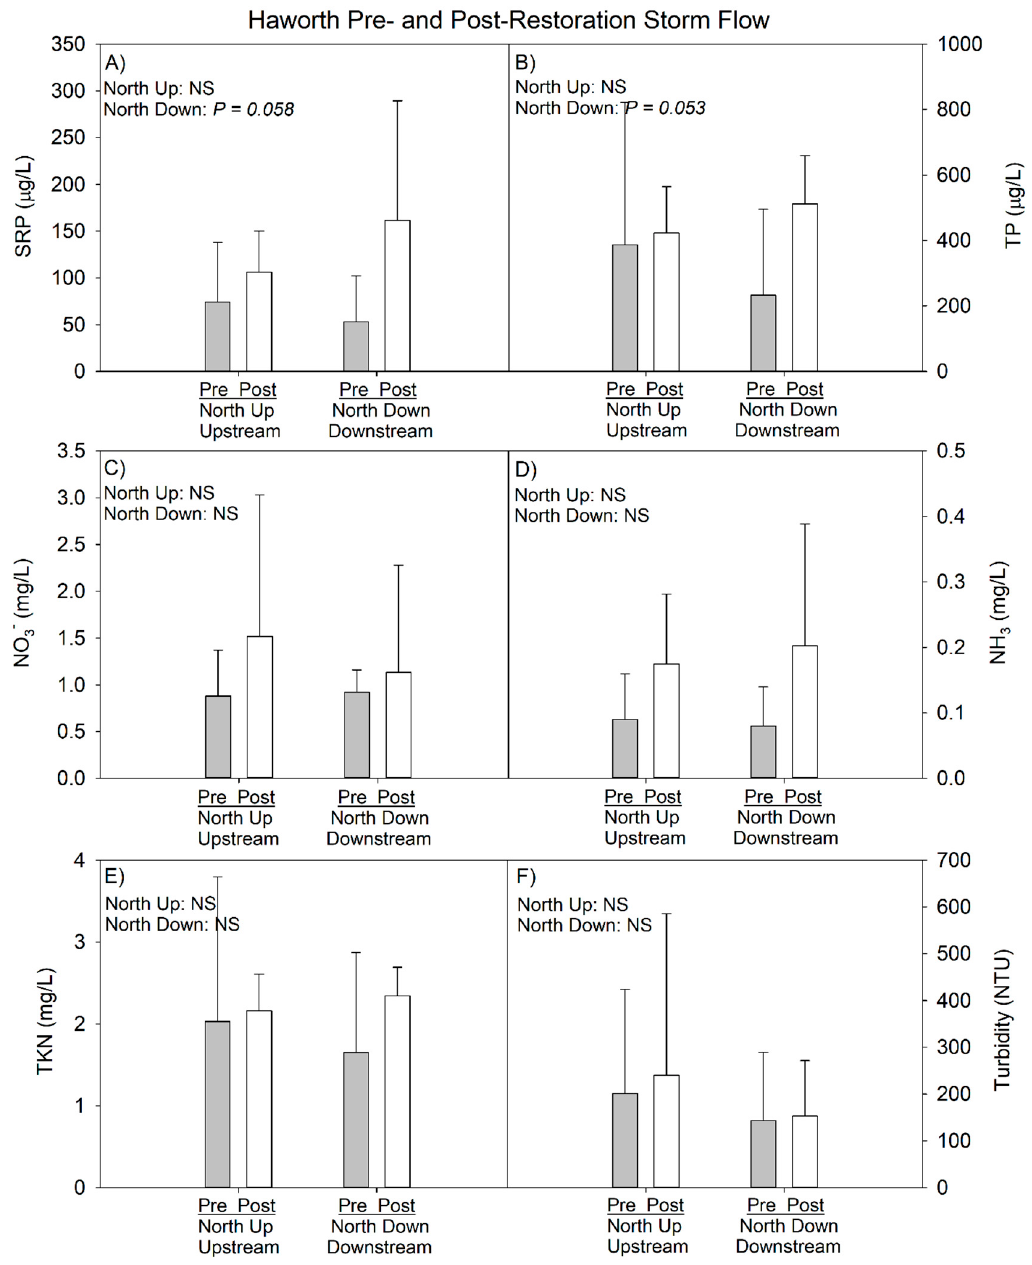
Figure 10. Haworth pre- and postrestoration water chemistry comparison at storm flow as of 2017 sampling year. Error bars represent 1 SD. p -values in top left corner of each panel represent pre- vs. postrestoration statistical analysis within each site. See Figure 1C for site locations.